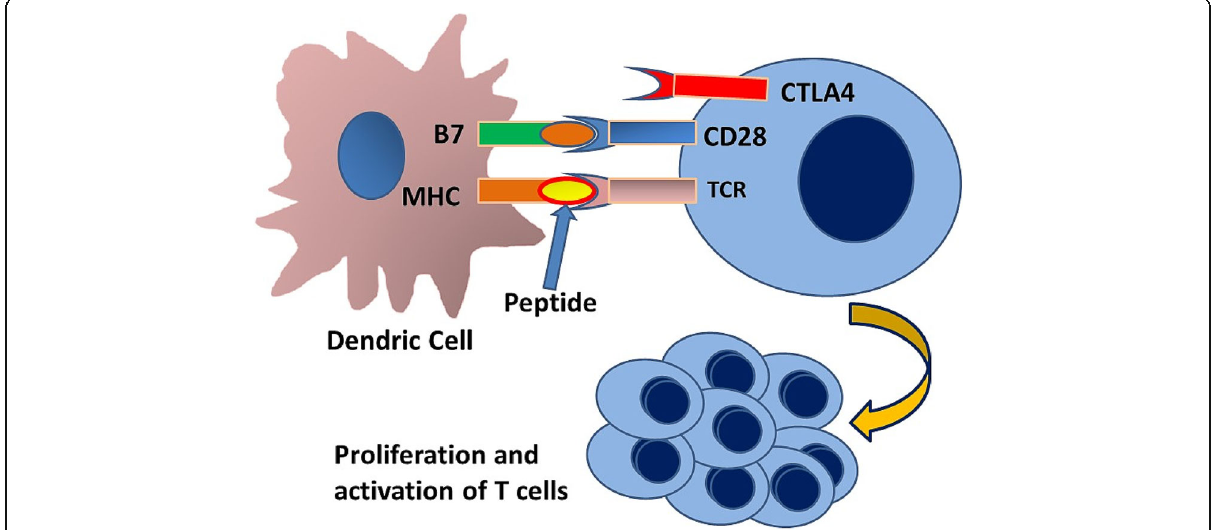
Fig. 2 Dendritic cells capture and process the cancer antigens and present these as peptides in association with MHC on the surface of the cells. The T-cell receptor on T- lymphocytes interacts with MHC and the peptide. In addition to binding to antigen-loaded MHC, T cells require a secondary signal to become activated. CD28 on the lymphocyte binds to the B7 on the surface of the dendritic cell. This interaction causes the T- cell to undergo stimulation and multiplication to become activated T-cells